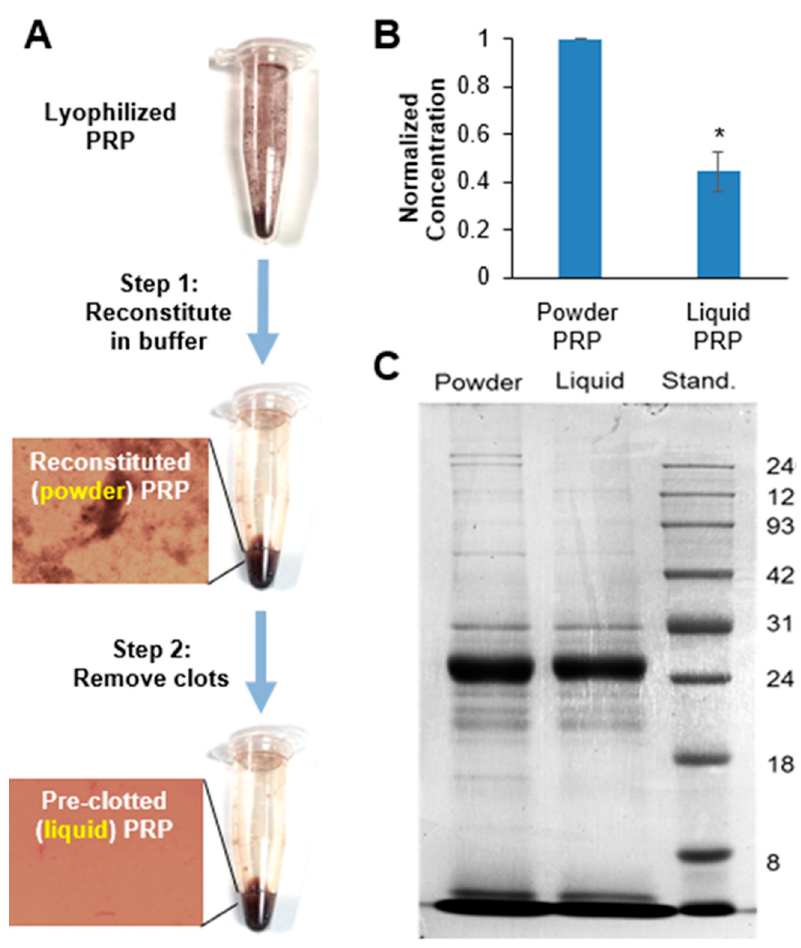
Figure 1. ( A ) Schematic of powder and liquid platelet-rich plasma (PRP) preparation. Lyophilized PRP is dissolved in bu ff er to prepare the powder PRP formulation. Powder PRP is then incubated for 24 h to form clots and clots are removed via centrifugation to prepare the liquid PRP formulation. Both powder and liquid PRP were used for further experiments. ( B ) Total protein content of reconstituted powder and pre-clotted liquid PRP. The total protein content was normalized by the protein content of the powder PRP. *denotes significant di ff erence compared to powder PRP ( p < 0.05). ( C ) Representative Coomassie-stained 1D electrophoresis gel.